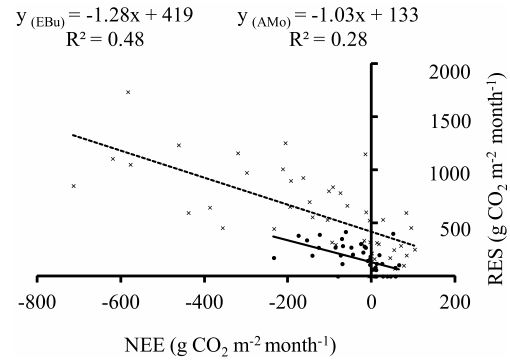
Fig. 5. Relationship between CO 2 respiration (RES), measured by chambers enclosing soil and some of the short vegetation, and net ecosystem exchange of CO 2 (NEE), measured by eddy covariance at Easter Bush (crosses and dotted trend line) and Auchencorth Moss (black circles and black trend line). Data are monthly sums for 2007 to